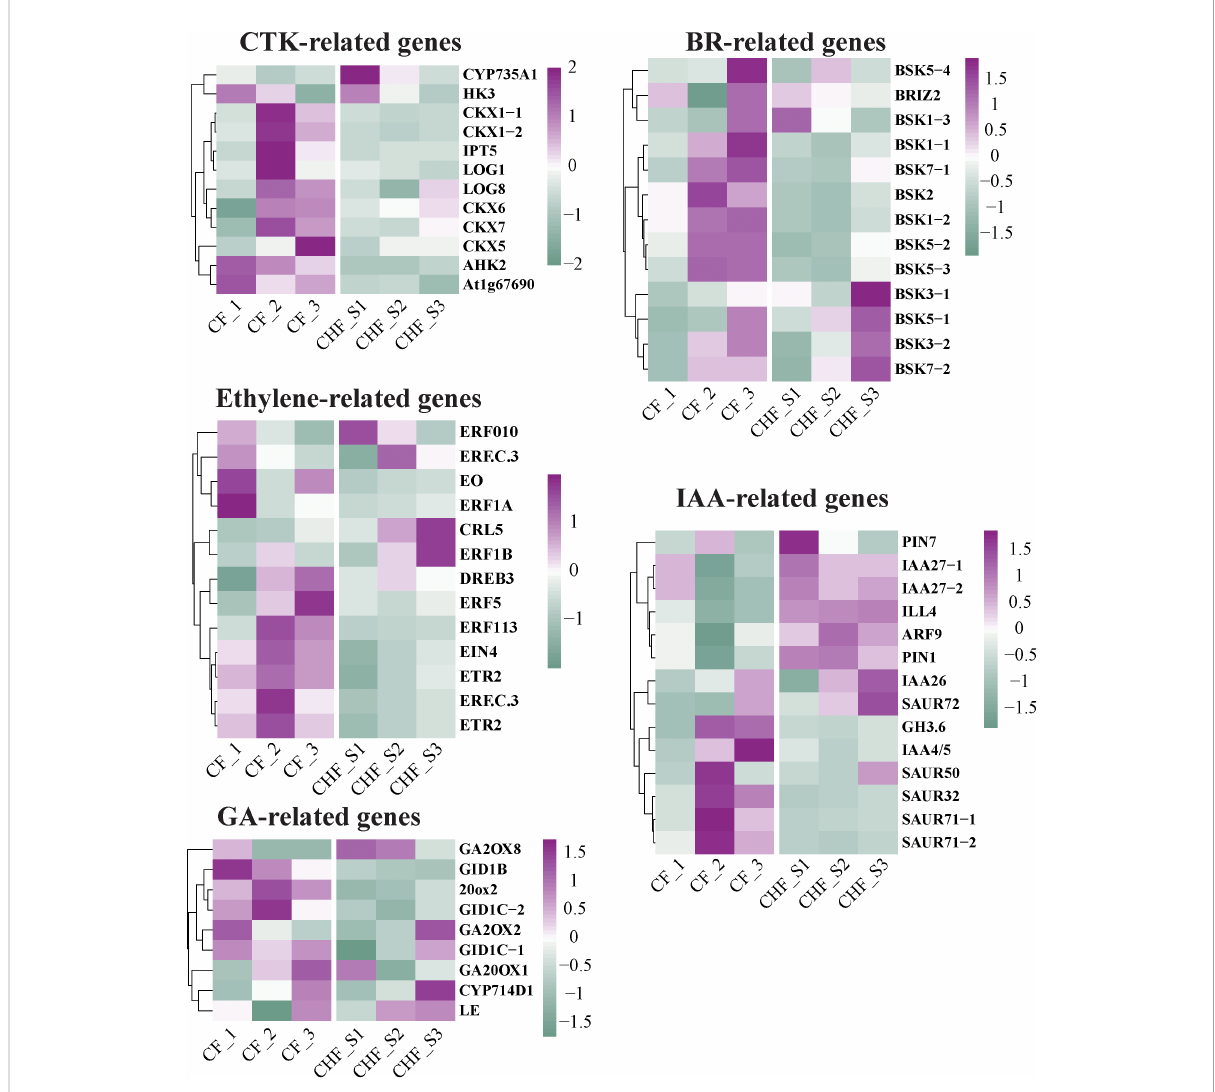
FIGURE 5 Changes in the differential expression of hormone-related genes in CF and CHF, including CTK, BR, IAA, ethylene, and